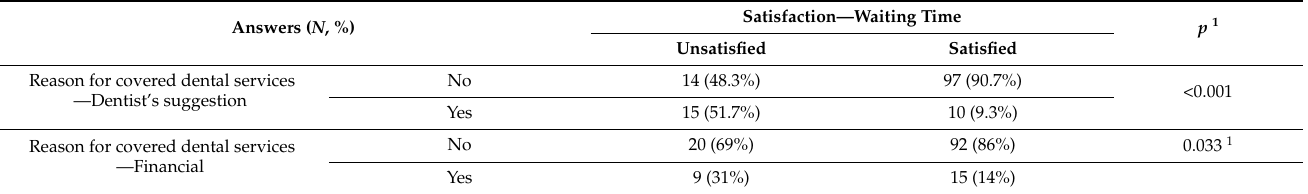
Table 10. Distribution of the participants according to the satisfaction about the waiting time for coverage and certain answers in the